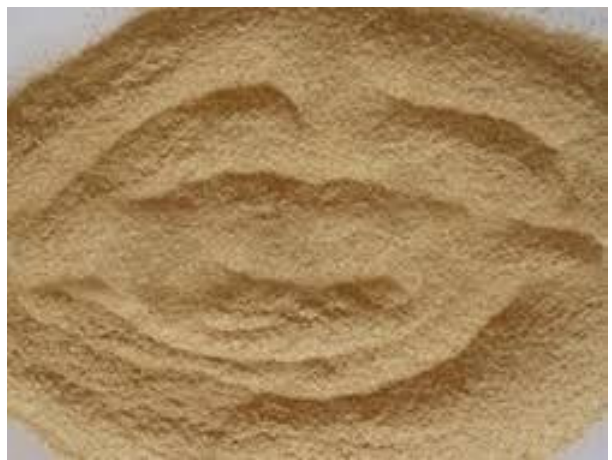
Figure 3. Rice husk powder (before processing into RHA).